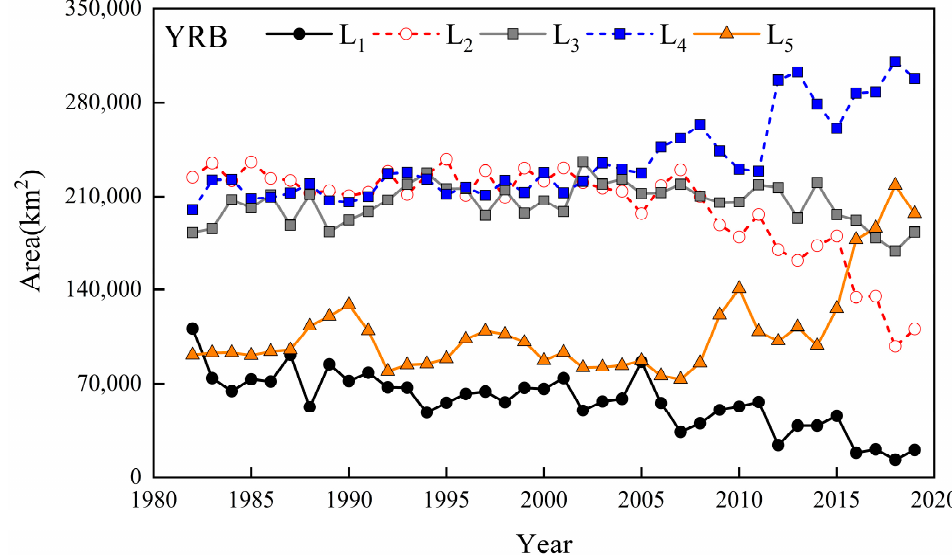
Figure 6. Temporal variation in the normal difference vegetation index (NDVI) at all levels in the Yellow River Basin (YRB). L 1 –L 5 represent NDVI levels of <0.2, 0.2–0.4, 0.4–0.6, 0.6–0.8, and >0.8 respectively.